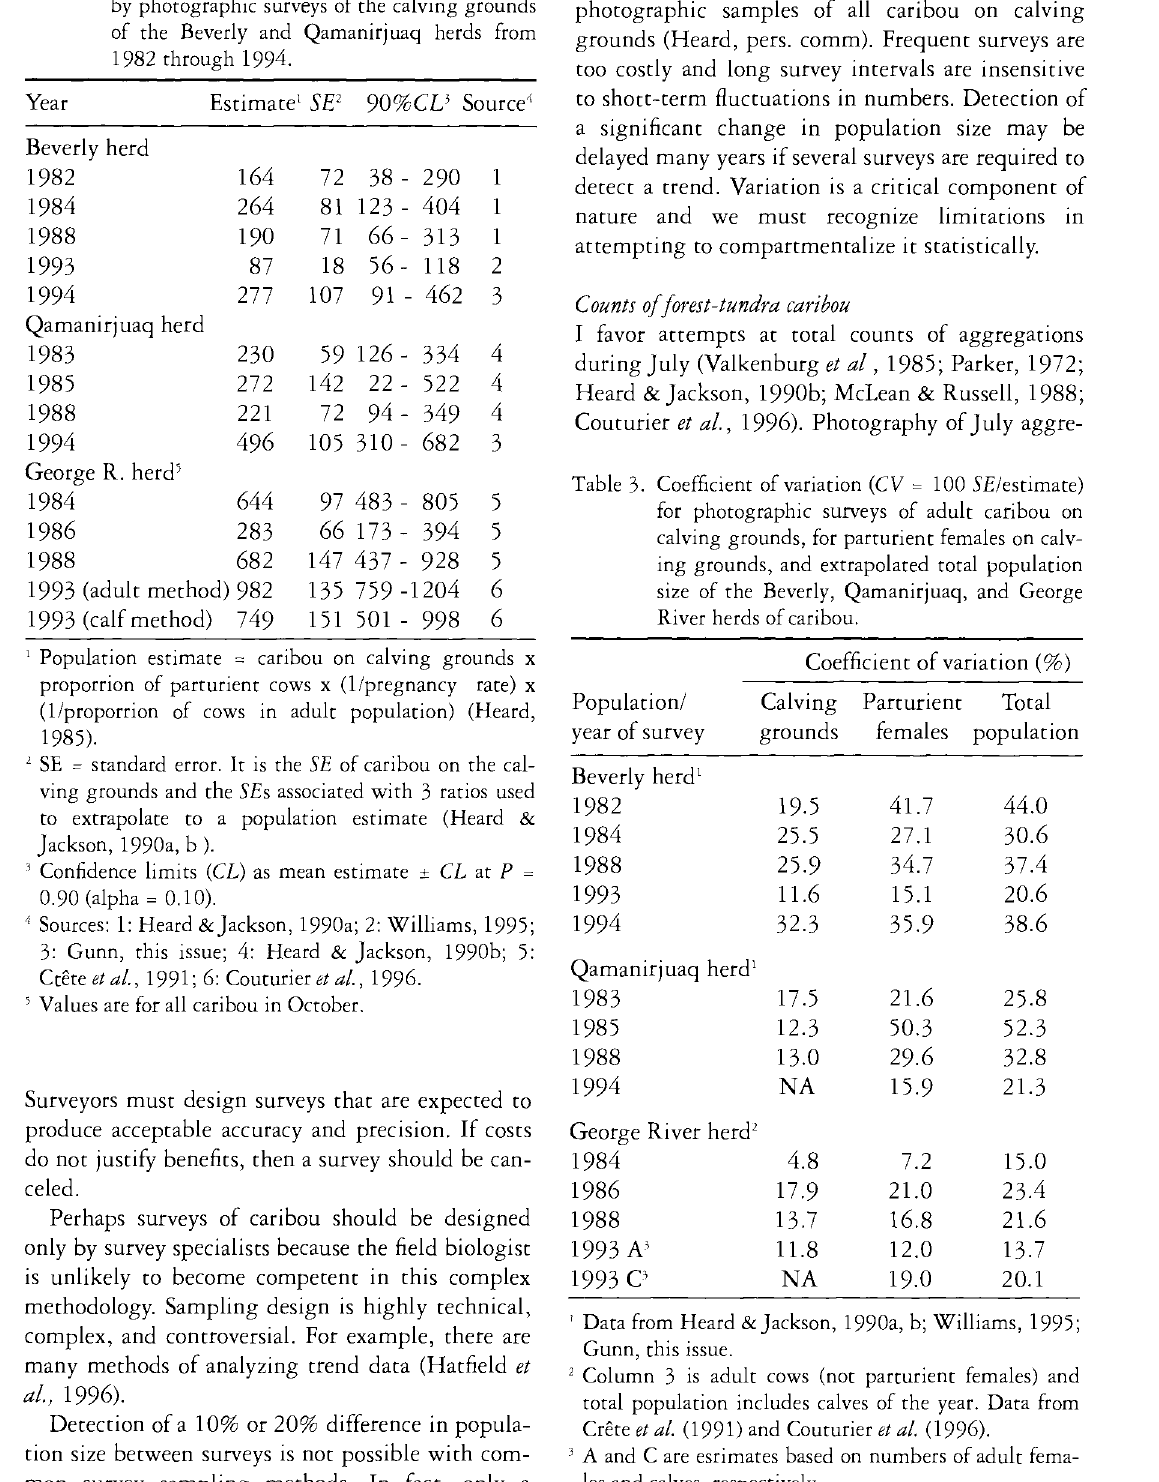
change of 50% between surveys is detected by most photographic samples of all caribou on calving grounds (Heard, pers. comm). Frequent surveys are too costly and long survey intervals are insensitive to shott-term fluctuations in numbers. Detection of